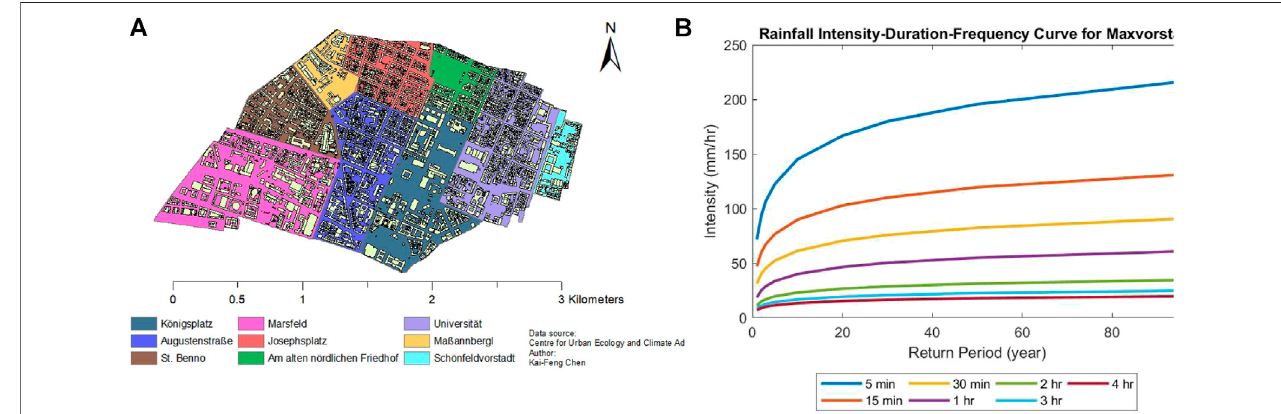
FIGURE 1 | (A) Location of the nine districts and buildings within Maxvorstadt, (B) Rainfall Intensity Duration Frequency curve of Maxvorstadt. Data retrieved from KOSTRA-DWD-2010R database (Grid No. 92049) containing information from 1951 to 2010, (Chen et al., 2018).